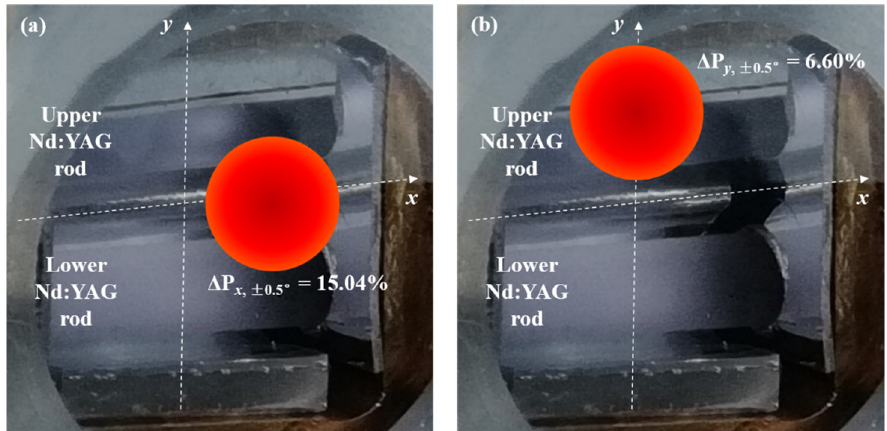
Figure 1. Photograph of the pump cavity with two Nd:YAG rods from the side-pumping prototype by Tibúrcio et al. [33]. Δ P is the variation of laser power observed when a deviation from optimal alignment occurs due to solar tracking error (±0.5° in the ( a ) x - and ( b ) y -axes).